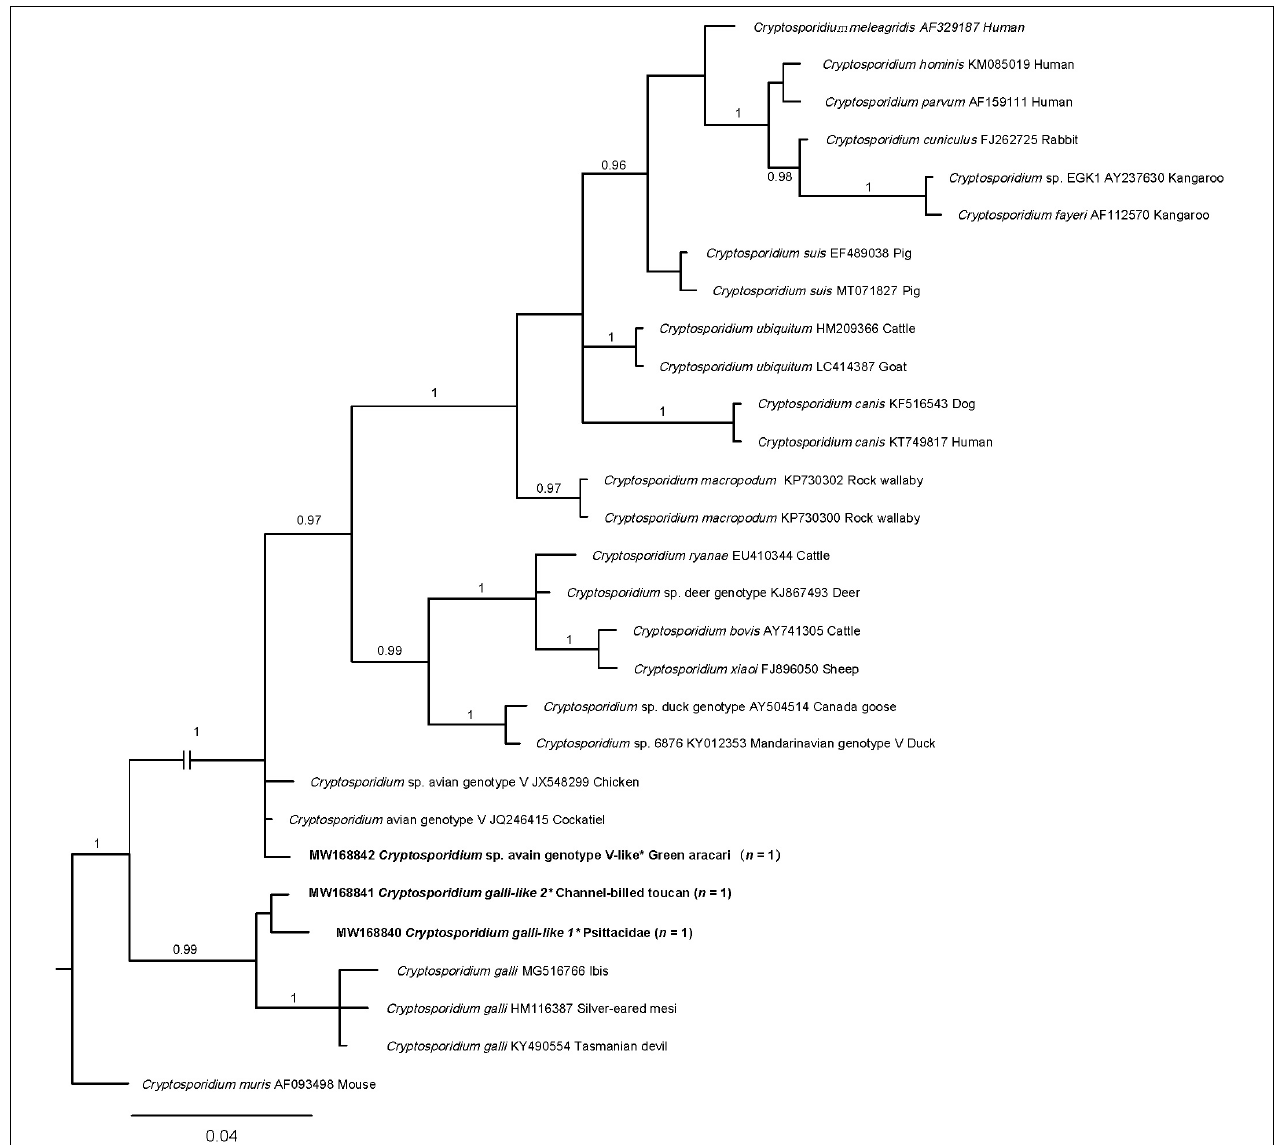
FIGURE 1 | Relationships among Cryptosporidium taxa inferred from the phylogenetic analysis of partial small subunit ribosomal rDNA gene ( SSU rDNA) sequence data by Bayesian inference (BI). Posterior probabilities are indicated at all major nodes. Bold font indicates Cryptosporidium species or genotypes characterized from fecal DNA samples in this study. In parentheses are the numbers of samples representing a particular species, genotype, and sequence (GenBank accession numbers indicated). Novel genotypes ( ∗ ). Scale bar represents the number of substitutions per site. Most clades were strongly supported ( pp = 0.96–1.00). pp < 0.95 was not